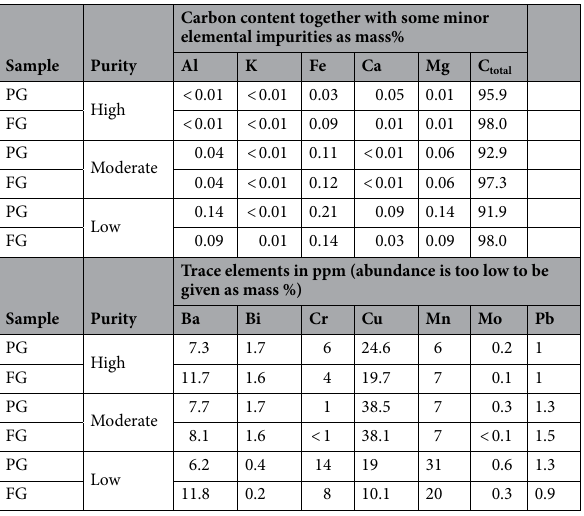
Table 2. Compositions of the graphite samples as determined by ICP-MS analysis.